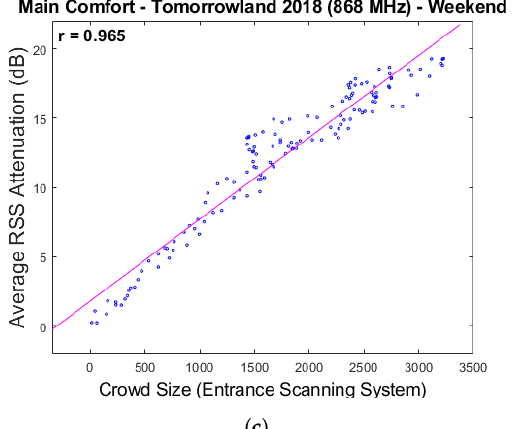
Figure 6. Scatter plots depicting the relationship between the average RSS attenuation and the crowd counts according to the scanning system in the Main Comfort environment. Plots ( a , b ) make use of the data from respectively Saturday 28 July 2018 and Sunday 29 July 2018, while plot ( c ) uses all available data from both days